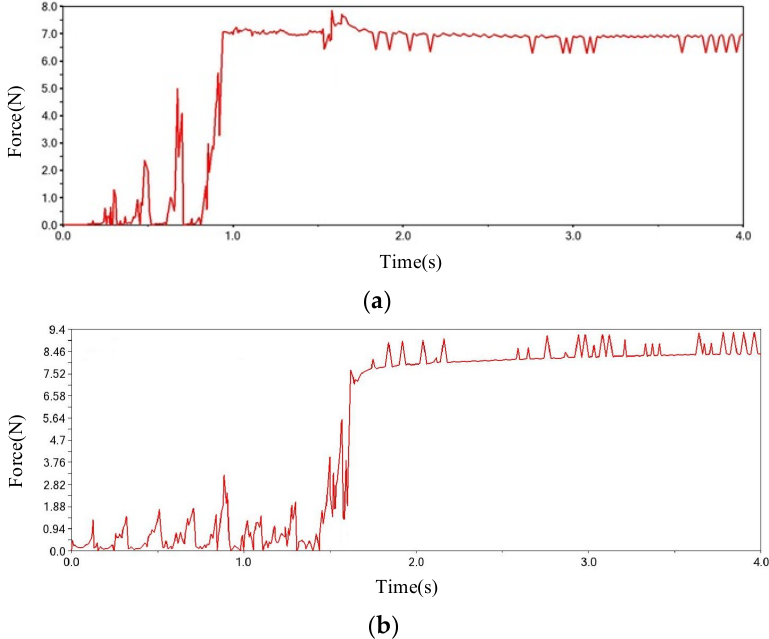
Figure 21. Change curve of contact force of clamping plate in Z direction: ( a ) front clamping plate, and ( b ) rear clamping plate.